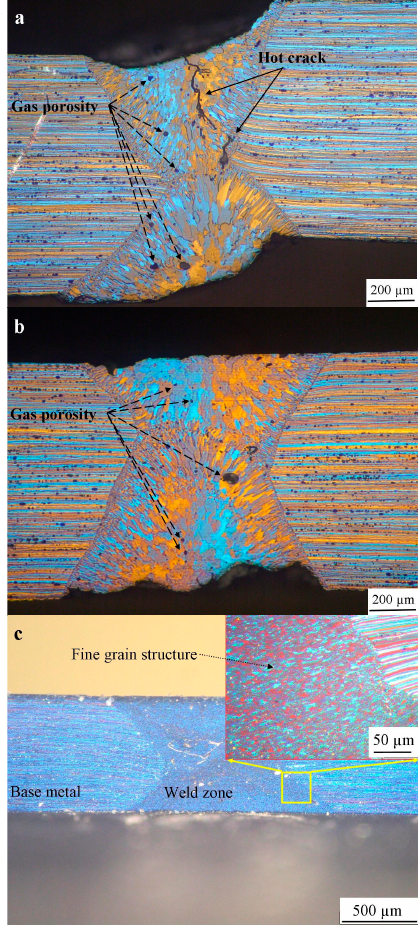
Figure 2. Microstructure of the welded alloy: ( a ) without filler metal; ( b ) with AlMg; and ( c ) with AlTiB filler